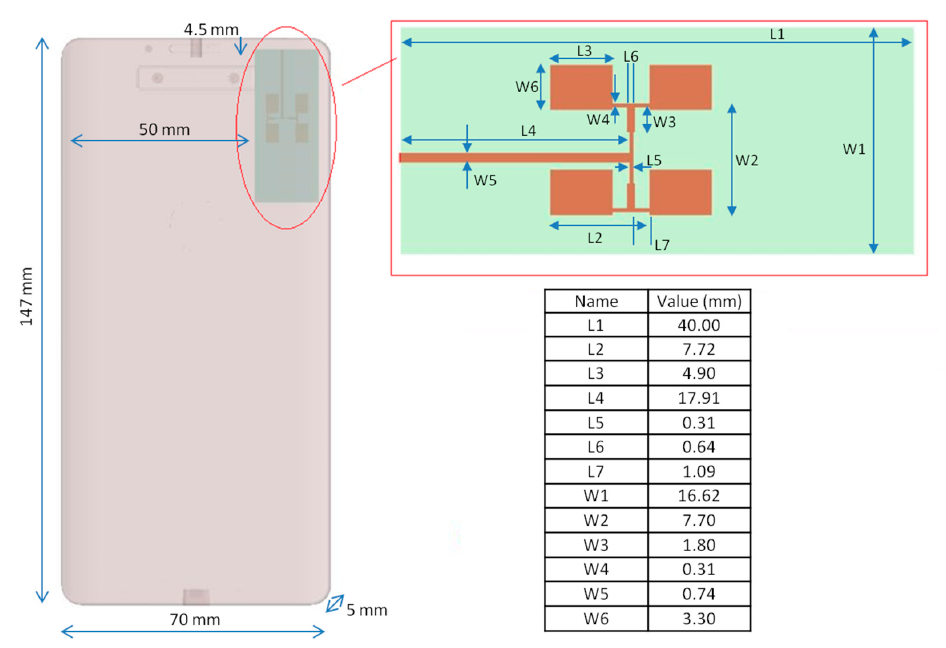
Figure 1. Smartphone with the antenna integrated and the size of the antenna elements.